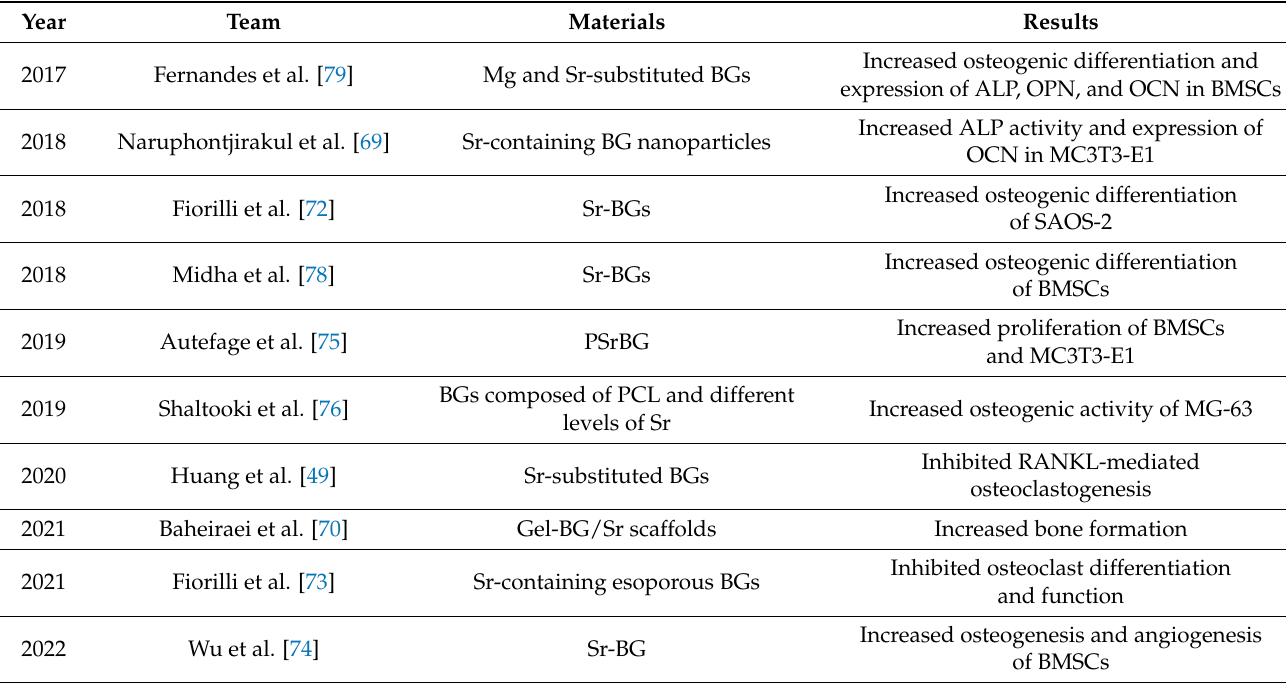
Table 2. The application of Sr compound with bioactive